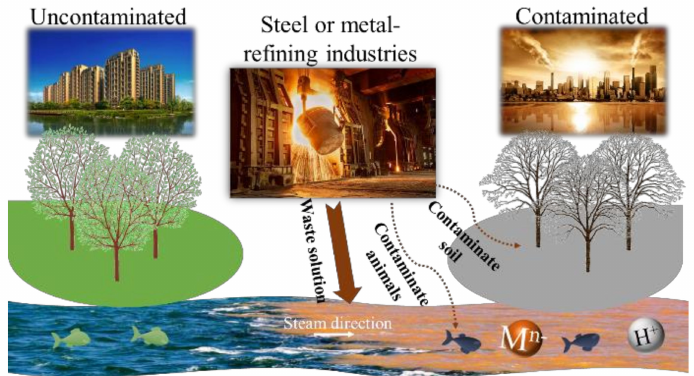
Figure 1. The schematic diagram for the influence from acid waste solutions.